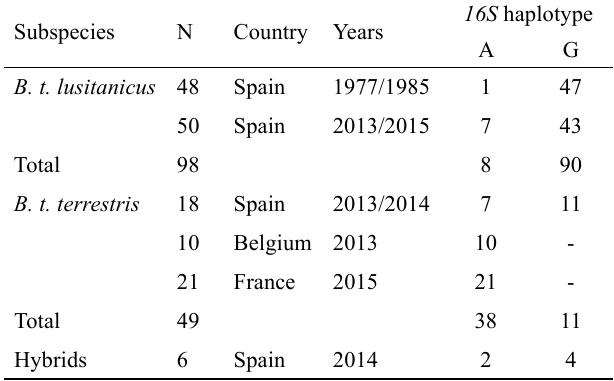
Table 1. Subspecies, number of Bombus terrestris individuals (N), country and years of sampling in the case study. Distribution of 16S haplotypes detected is also